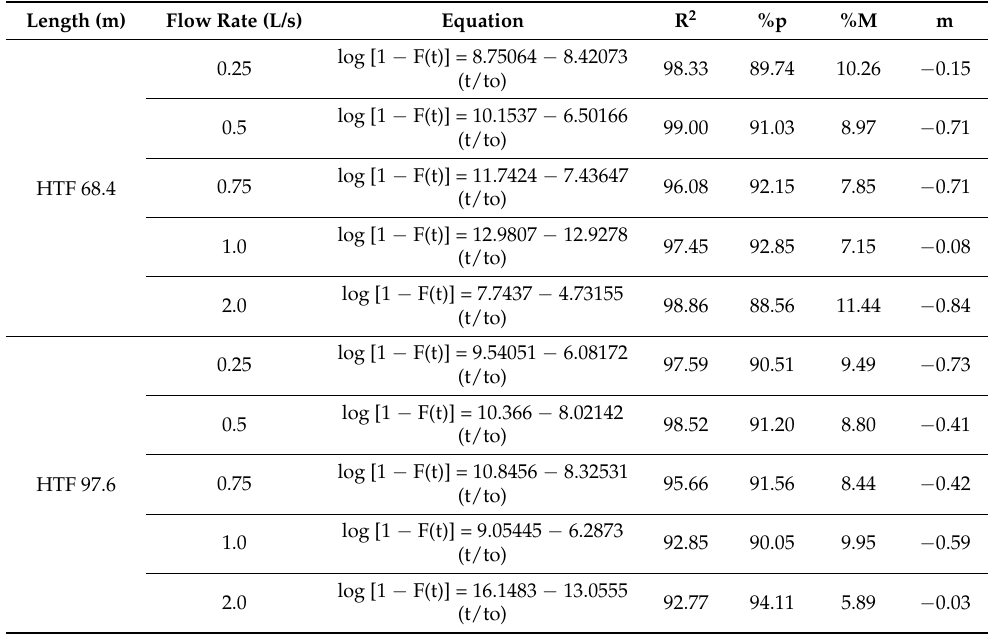
Table 2. Application Results of the Wolf–Resnick Model in the Tubular